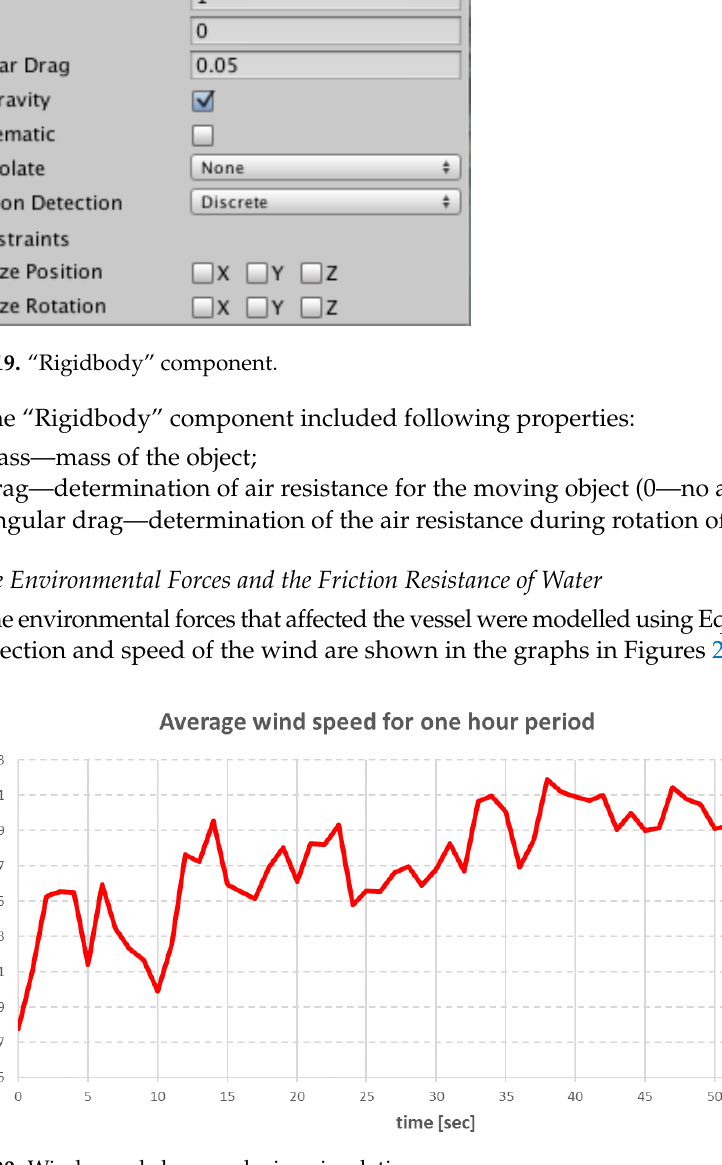
Figure 21. Wind direction changes during simulation. The above charts were plotted from data read from the wind sensor on the real ship during the research. The wind direction shown in Figure 21 was the true wind, and due to this fact, the wind was converted to be relative to the ship. The speed of the sea current was taken as an average value of 0.25 (m/s) based on the values shown in Figure 9. The direction of the sea current was taken as the wind di- rection. Unity3d has several methods for interacting with a given force on an object. For ex- ample, there are methods from the “ Rigidbody ” component, such as AddForce(), Ad- dRelativeForce(), AddTorque(), AddRelativeTorque(), but their disadvantage is that they interact with the object “ impulsively ” , i.e., one call of a method is equivalent to one push of the object with a given force. A second way to interact with an object with a given force is to use the “ Constant Force ” component (Figure 22).